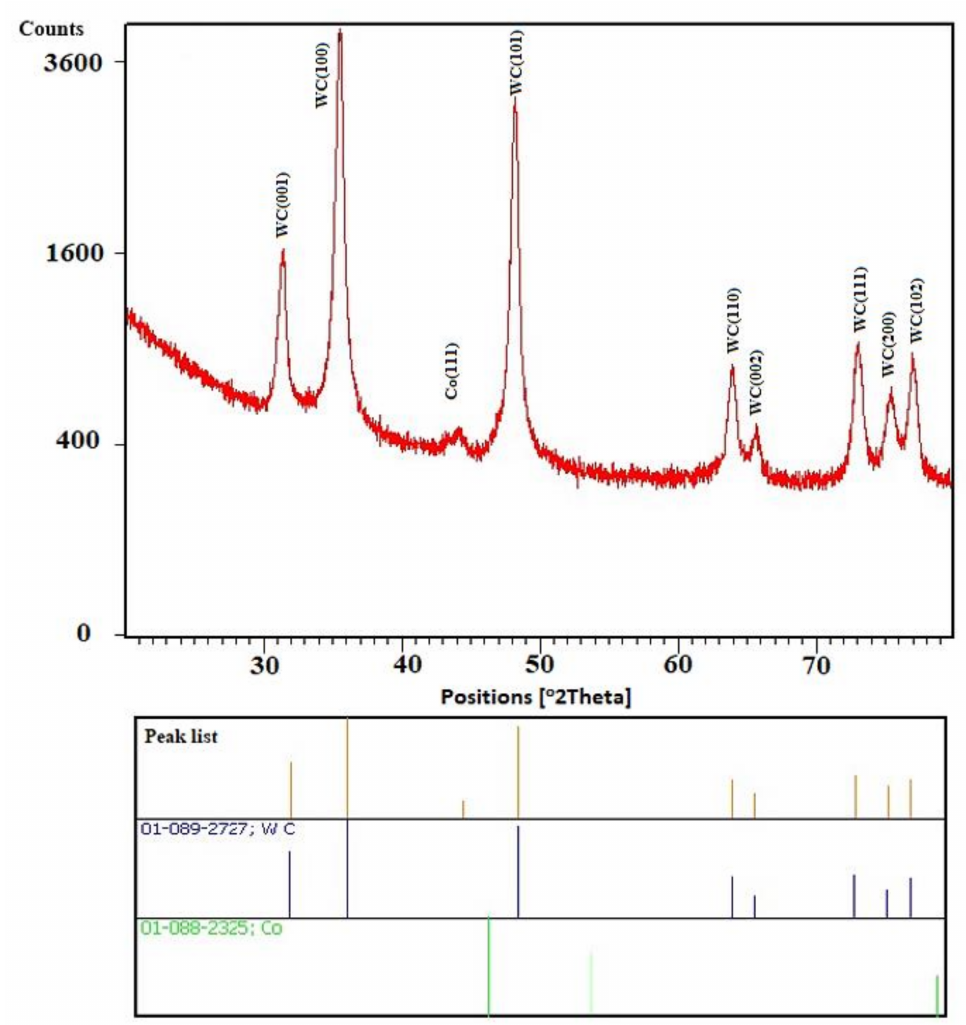
Figure 5. X-ray diffractograms of the tool